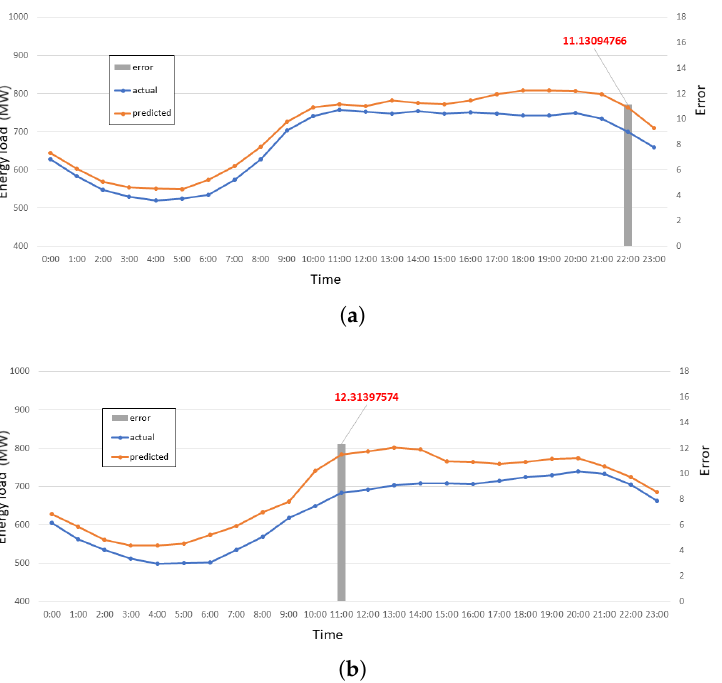
Figure 18. Highest errors recorded due to sudden weather changes. ( a ) Error during rainy day; ( b ) Error on the day of Typhoon Danas.